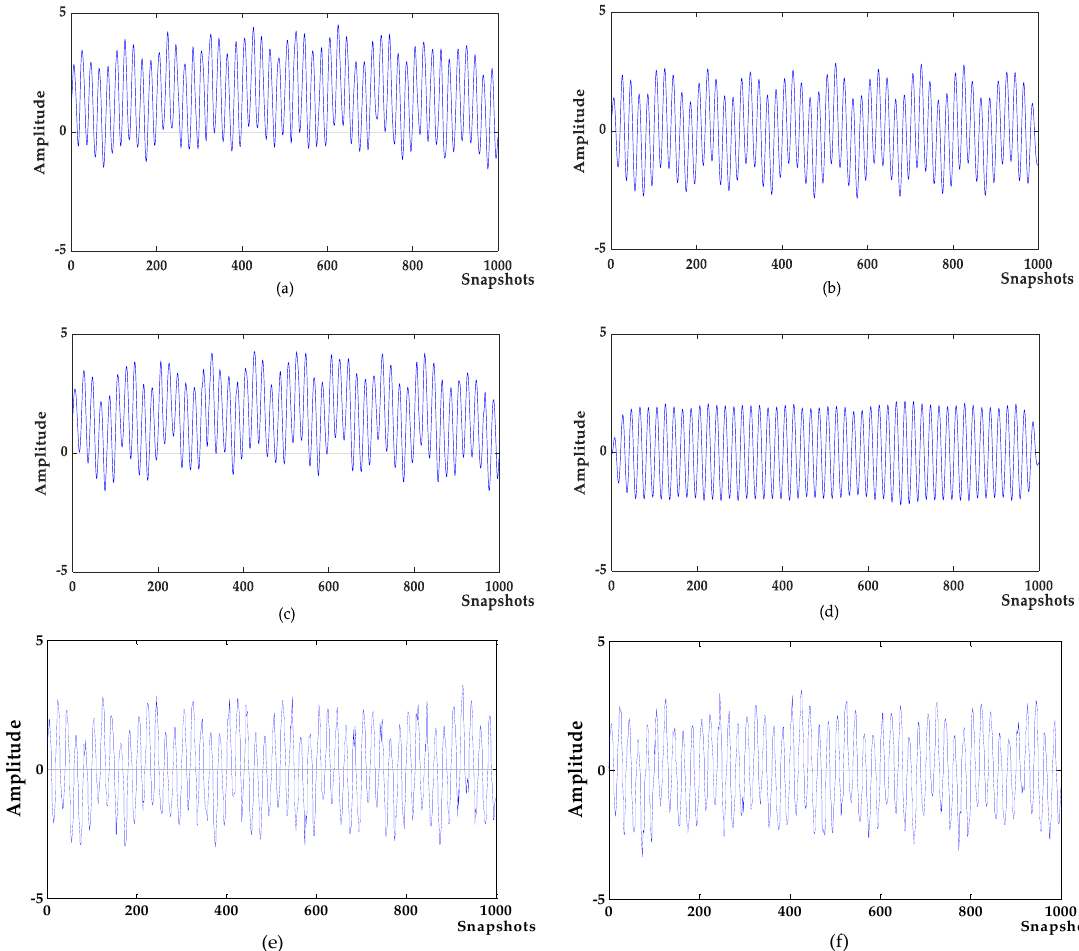
Figure 4. The denoising results of different algorithms. ( a ) variational mode decomposition-new permutation entropy (VMD-NPE); ( b ) 2VMD-correlation coefficient (CC); ( c ) empirical mode decomposition and wavelet analysis (EMD-WT); ( d ) WOA-VMD-CC; ( e ) least squares fitting with